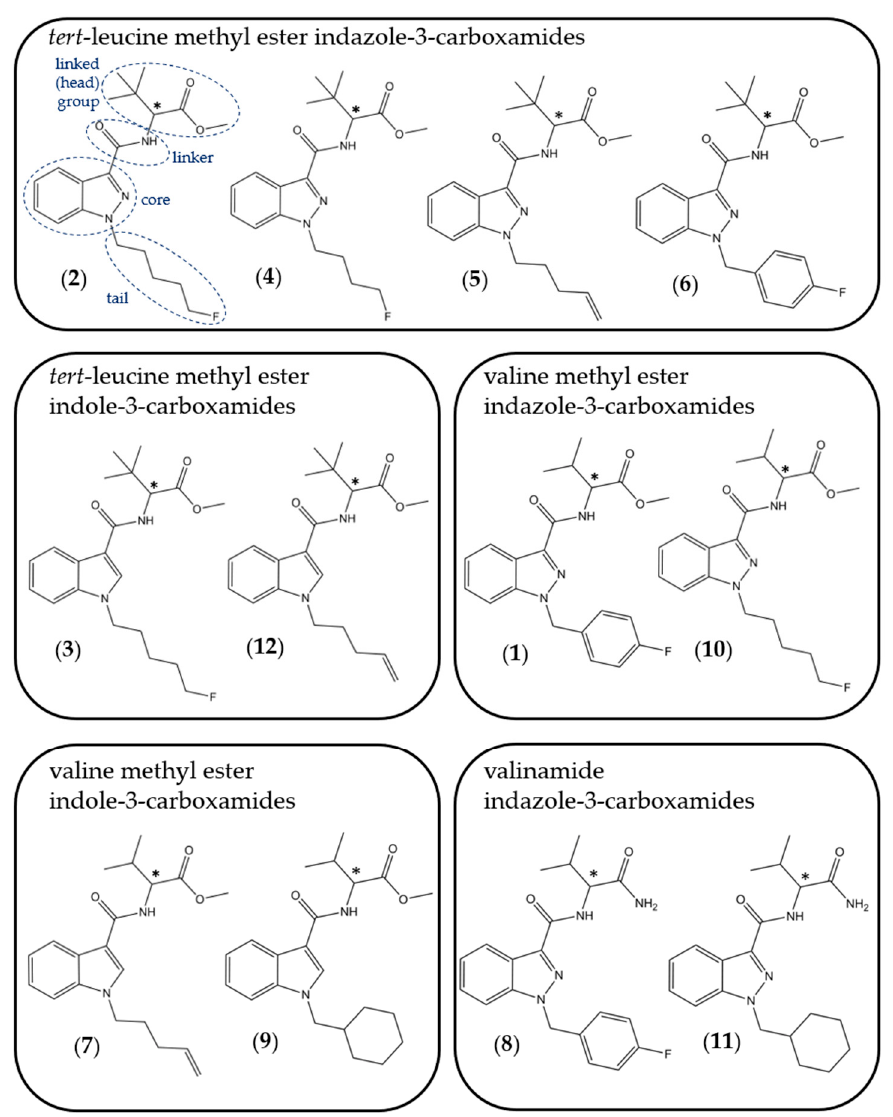
Figure 1. Structures of synthetic cannabinoid receptor agonists (SCRAs) involved in this study. ( 1 ) AMB-FUBINACA; ( 2 ) 5F-MDMB-PINACA; ( 3 ) 5F-MDMB-PICA; ( 4 ) 4F-MDMB-BINACA; ( 5 ) MDMB-4en-PINACA; ( 6 ) MDMB-FUBINACA; ( 7 ) AMB-4en-PICA; ( 8 ) AB-FUBINACA; ( 9 ) AMB-CHMICA; ( 10 ) 5F-AMB-PINACA; ( 11 ) AB-CHMINACA; ( 12 ) MDMB-4en-PICA. Asterisk (*) indicates chiral centre. Numbering used in the Figure reflects the order in which structures are mentioned in the text.